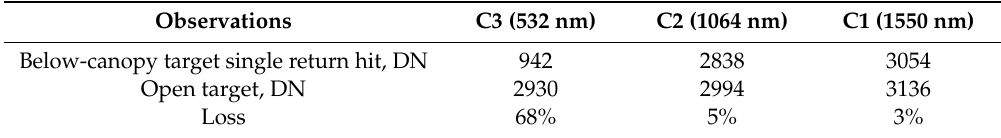
Table 7. Below-canopy single return DNs vs. open target DNs and the corresponding loss in intensity values in percentage. DN values were normalized to a 600 m range and corrected with the cosine of incidence angle. Only one hit (N = 1) for each channel was detected for the below-canopy target. Observations C3 (532 nm) C2 (1064 nm) C1 (1550 nm) Below-canopy target single return hit, DN 942 2838